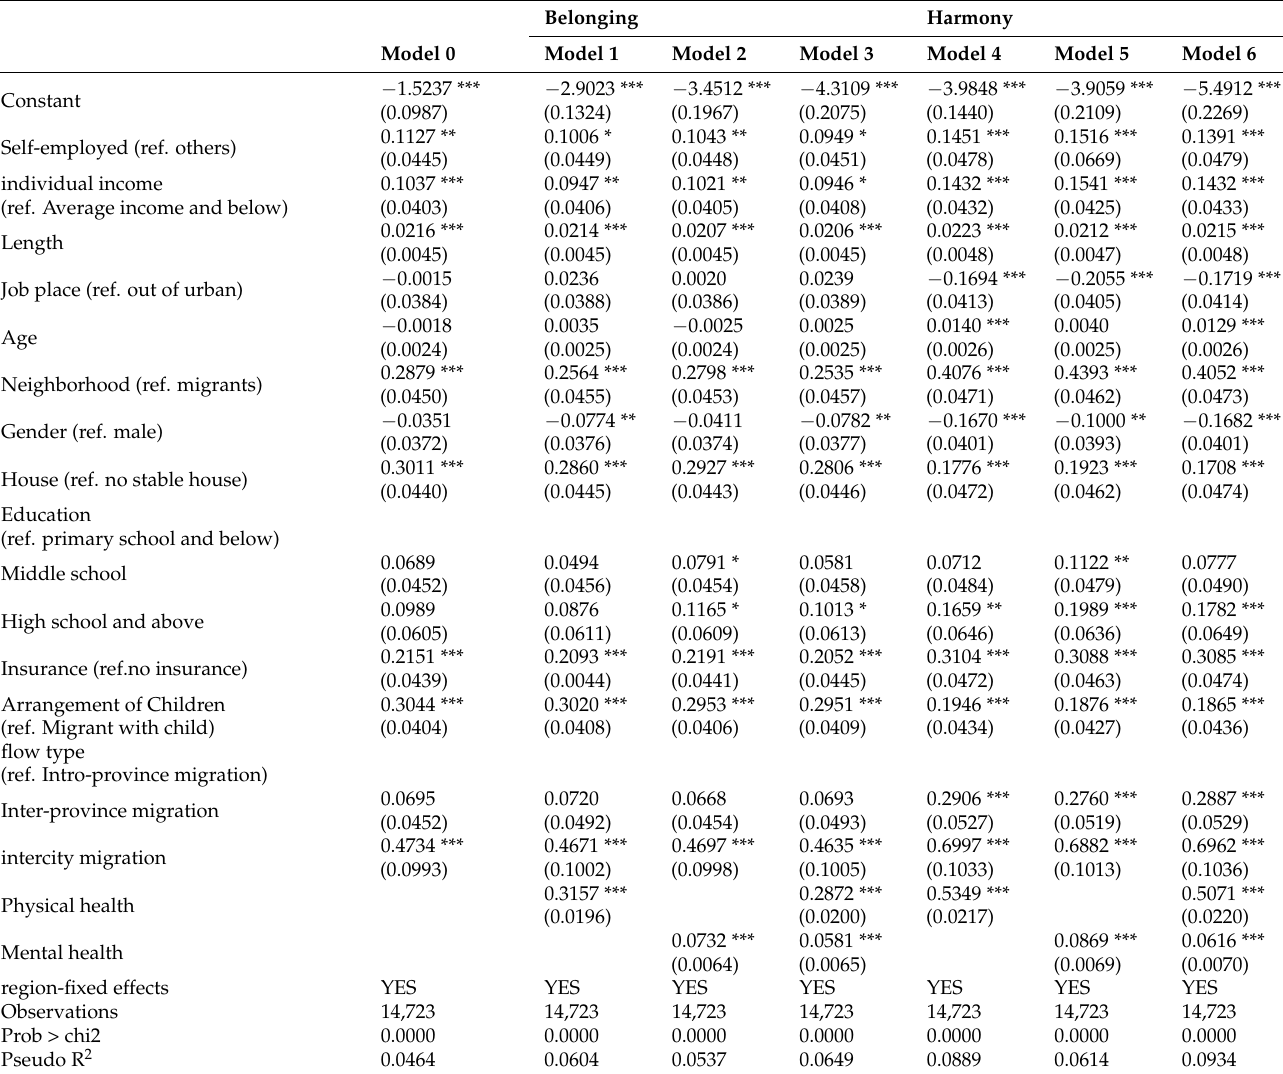
Table 2. Logistic regression results on the effects of physical and mental health of migrants. Belonging